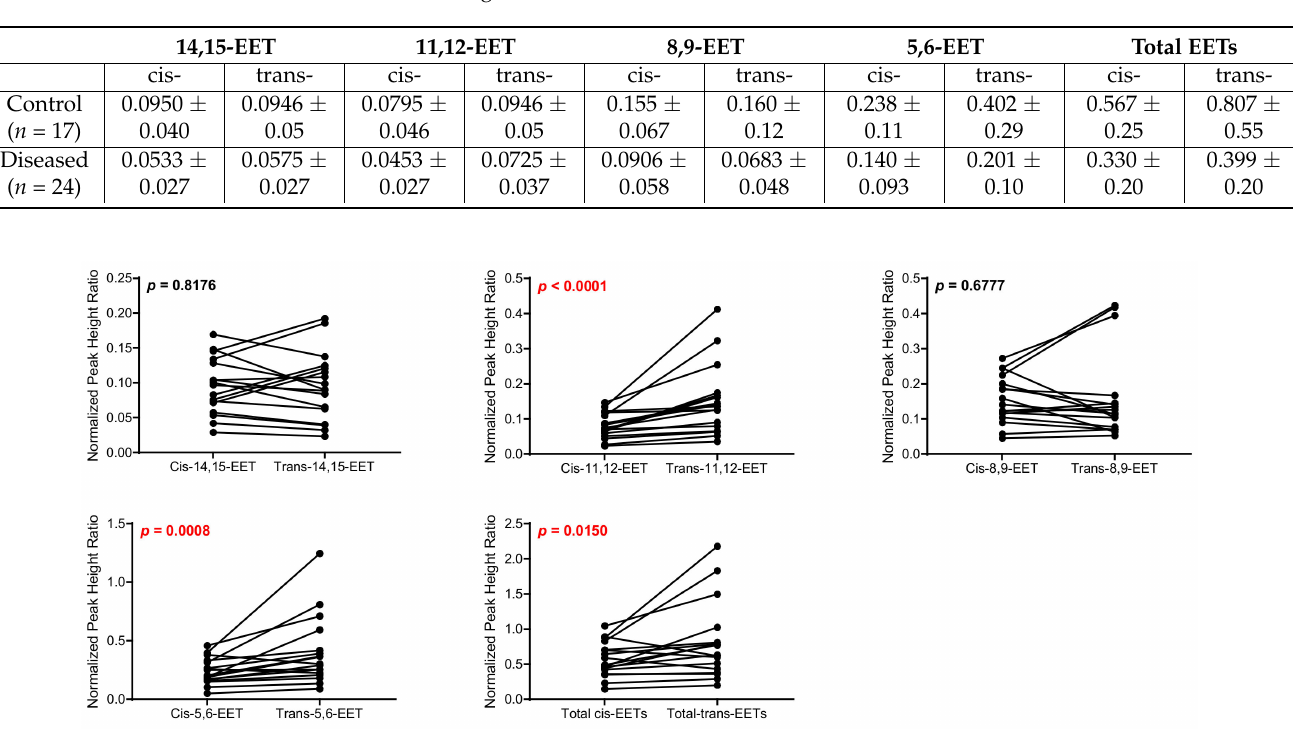
Figure 4. Comparison of total cis -EETs and corresponding total trans -EETs levels among the different regioisomers in control cardiac tissue. Connecting lines between two points indicate matched pairs of the total cis - and trans -EETs from the same samples.